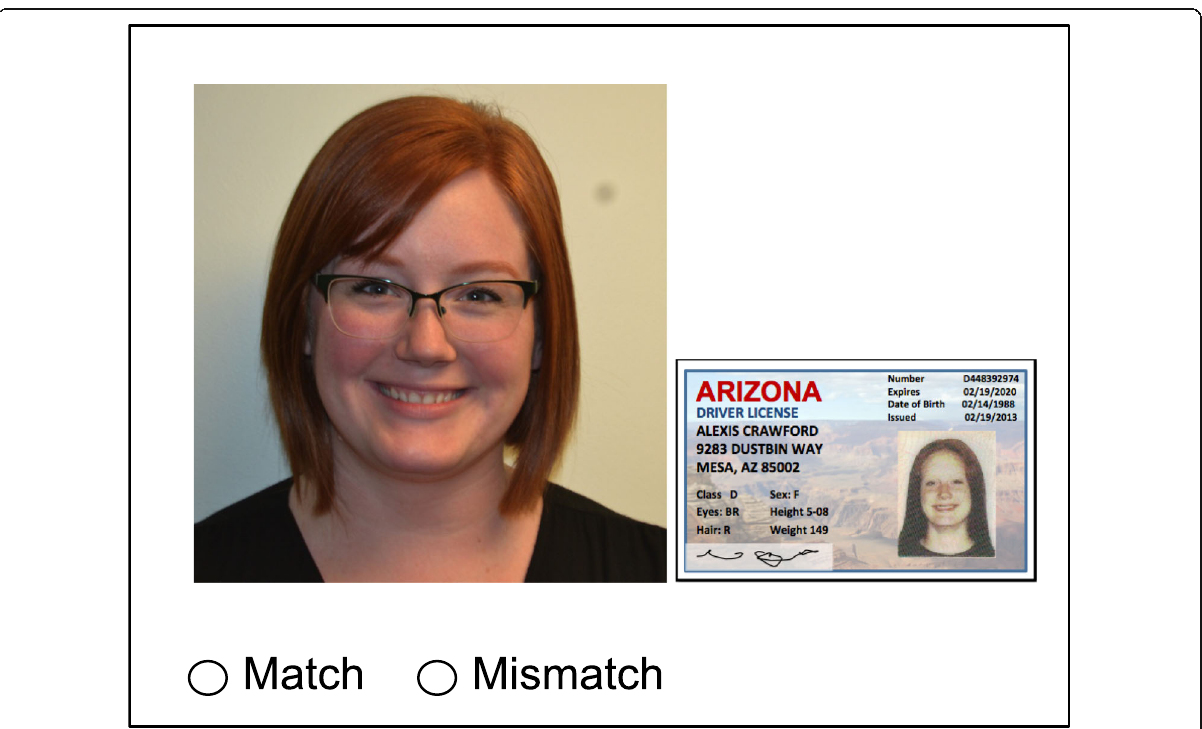
Fig. 1 Sample “ match ” trial. Note that the sample depicts a volunteer who consented to the use of her likeness and was not one of the stimuli used in the